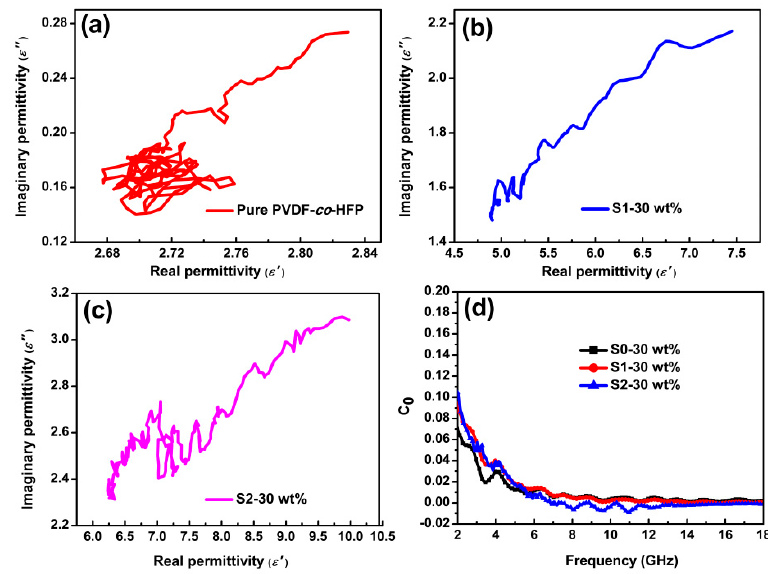
Figure 5. Cole-cole ( a – c ) and C 0 ( d ) curves for all the samples.